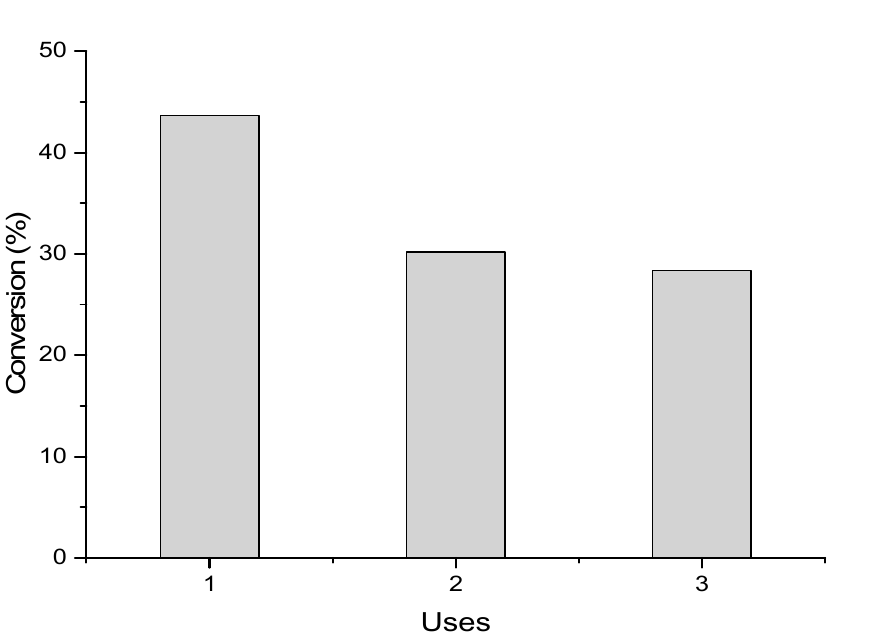
Figure 10. Reusability of 1%Ir:2%Pd/C after three reactions. Reaction conditions: 31 mg of catalyst, 25 °C, 0.5 M FA, 700 rpm, 2 h reaction time.